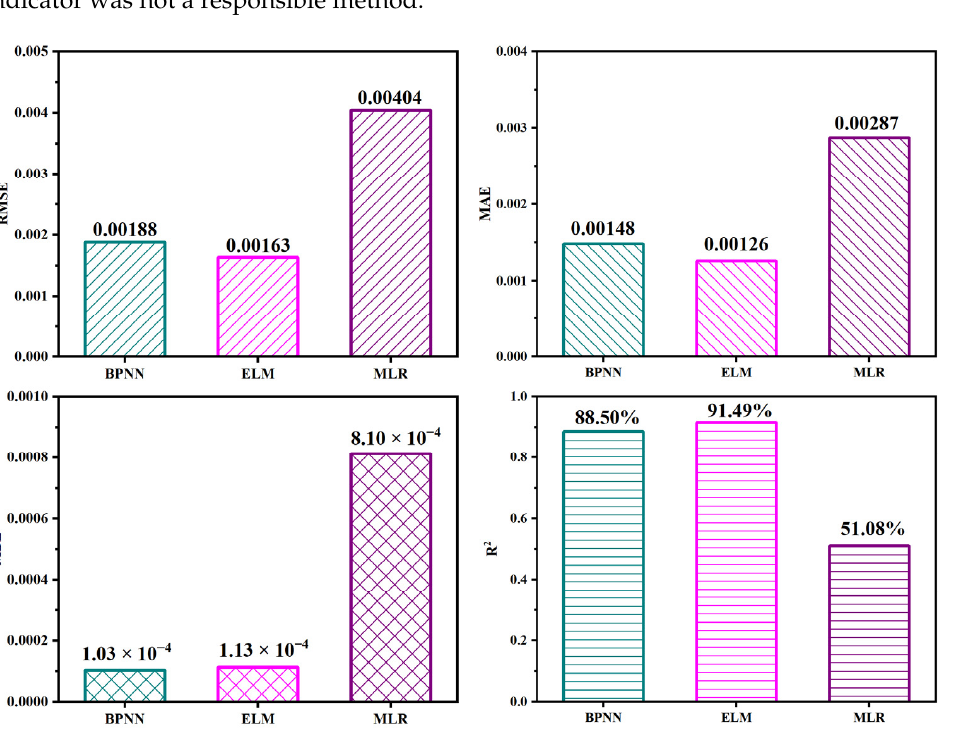
Figure 13. The test phase performance indicators of three best developed models.